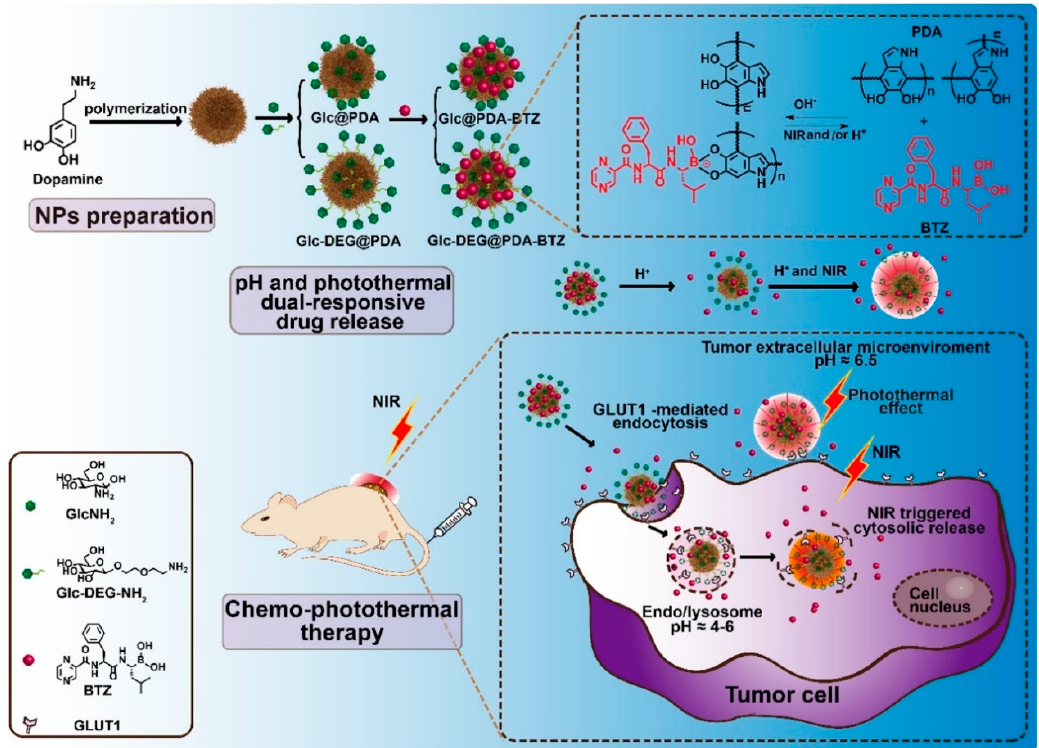
Figure 6. Schematic illustration of the construction of glucose-functionalized polydopamine (PDA) nanoparticles with pH and photothermal dual-responsive and photothermally triggered cytosolic drug delivery properties for the GLUT1-targeting chemo-phototherapy. Reproduced with permission from [96]; Copyright 2020 Elsevier Ltd.